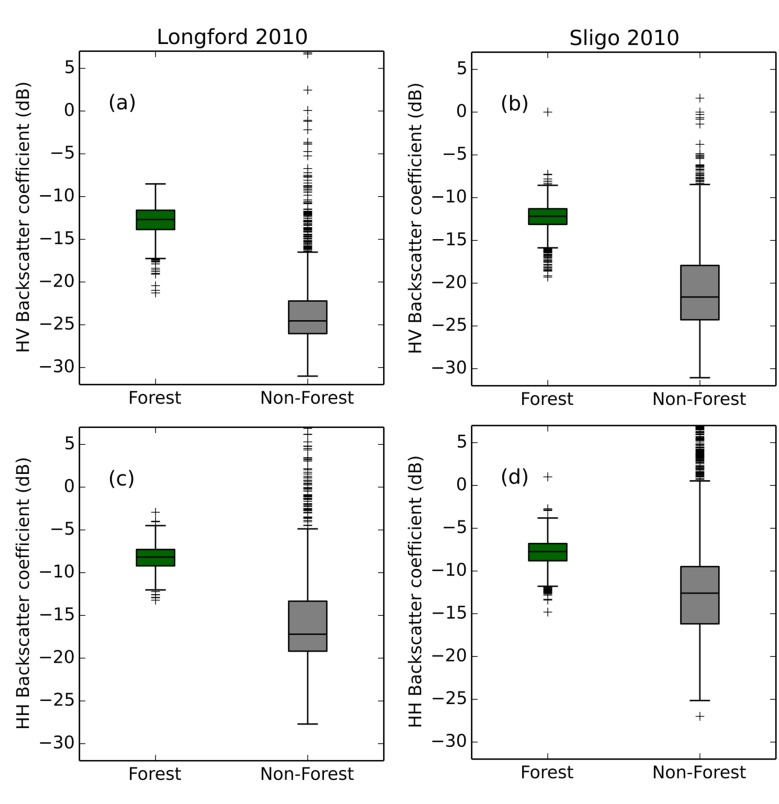
Box plots of median L-band HH and HV backscatter (γ°) for forest and non-forest training samples for Longford and Sligo.